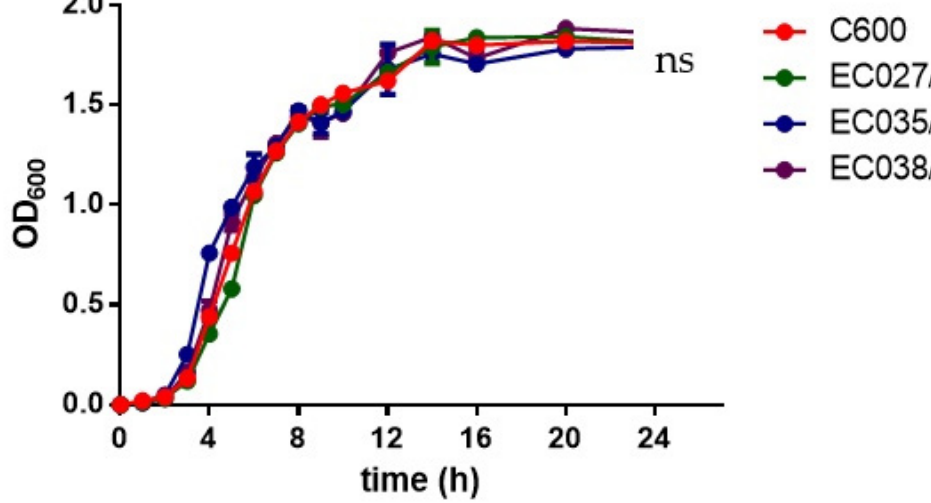
Figure 4. Growth curves for 3 transconjugants and C600. There was no overall significant difference